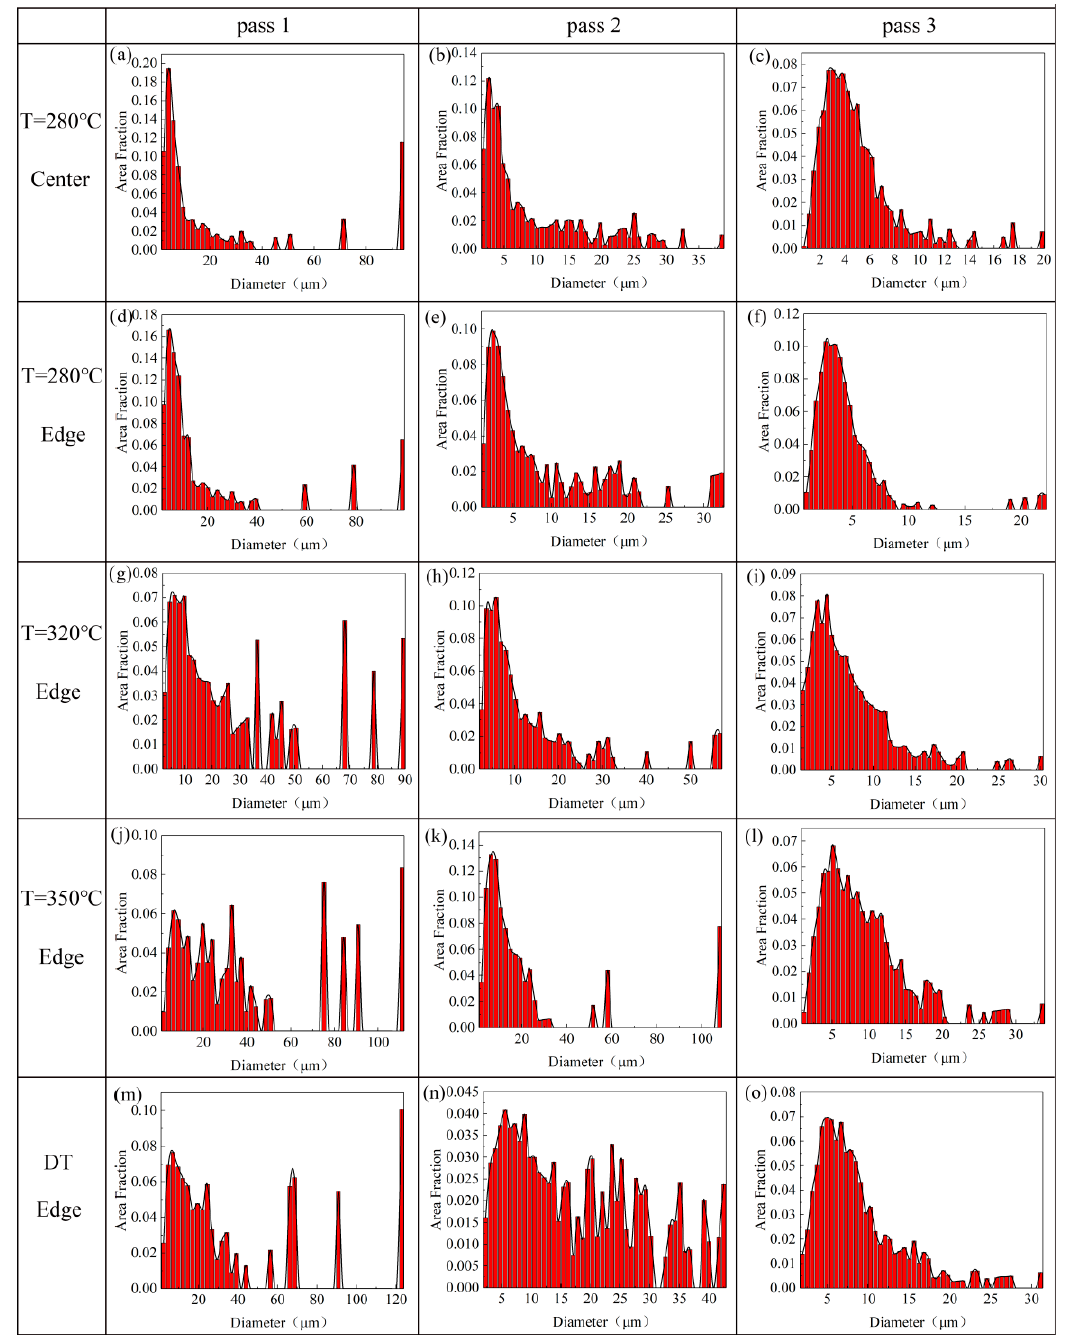
Figure 9. The grain size distribution maps of the CEE-AEC samples at di ff erent temperatures: ( a ) Center pass 1 at 280 ◦ C; ( b ) Center pass 2 at 280 ◦ C; ( c ) Center pass 3 at 280 ◦ C; ( d ) Edge pass 1 at 280 ◦ C; ( e ) Edge pass 2 at 280 ◦ C; ( f ) Edge pass 3 at 280 ◦ C; ( g ) Edge pass 1 at 320 ◦ C; ( h ) Edge pass 2 at 320 ◦ C; ( i ) Edge pass 3 at 320 ◦ C; ( j ) Edge pass 1 at 350 ◦ C; ( k ) Edge pass 2 at 350 ◦ C; ( l ) Edge pass 3 at 350 ◦ C; ( m ) Edge pass 1 at DT; ( n ) Edge pass 2 at DT; ( o ) Edge pass 3 at